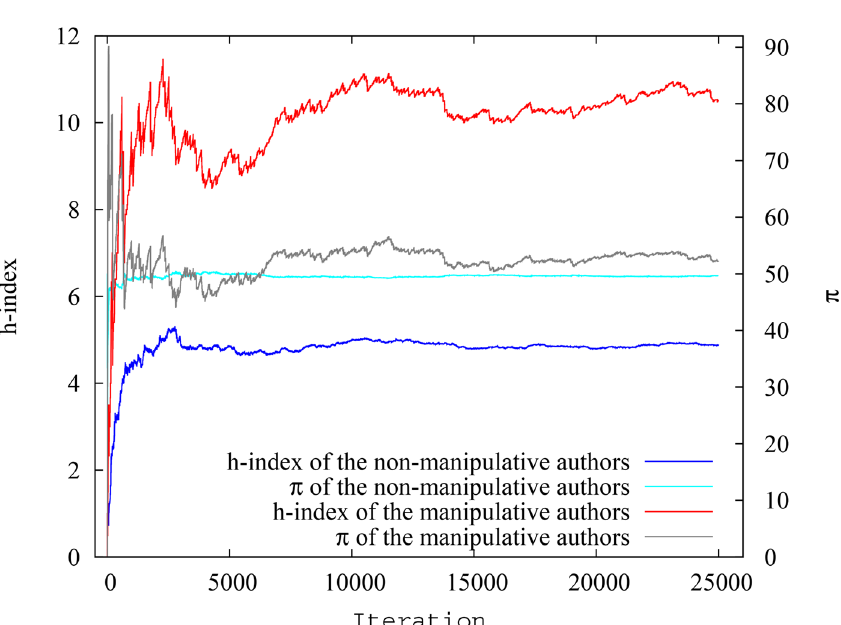
Fig 5. Variation of average h-index and pagerank-index for non-manipulative and manipulative authors at each timestep for simulation scenario 1. The difference is much smaller between the two groups when pagerank-index is